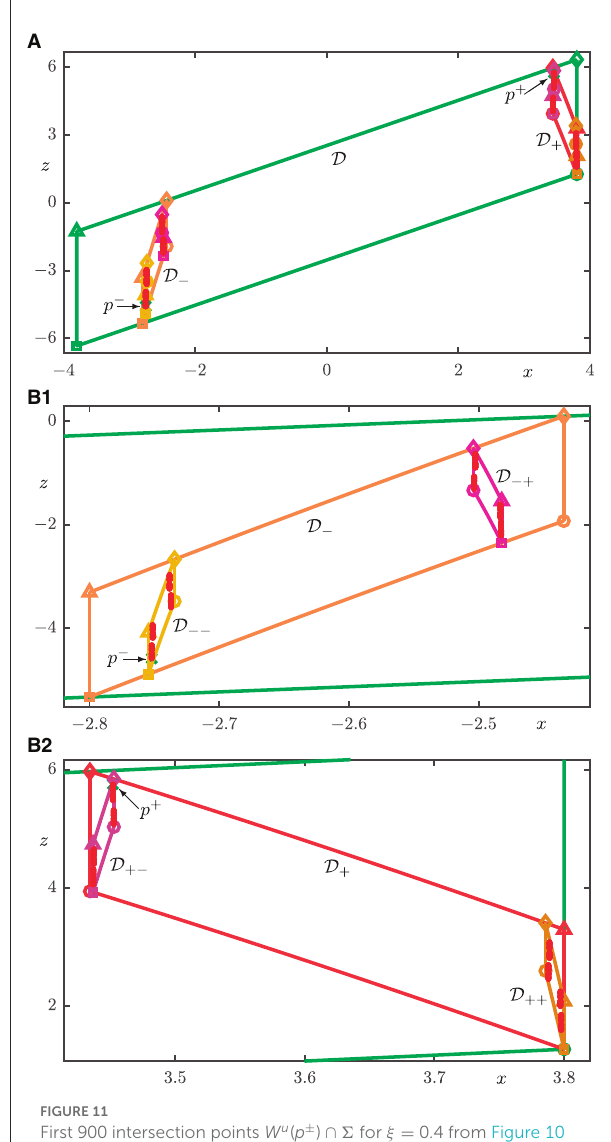
FIGURE11 First 900 intersection points W u ( p ± ) ∩ 6 for ξ = 0.4 from Figure 10 shown together with p ± and the intersection sets of D (green), D − (orange), D + (red), D −− (yellow), D −+ (magenta), D +− (dark magenta), and D ++ (light brown). (A) shows all of 6 ∩ D , and (B1, B2) are enlargements of D − and D + ,